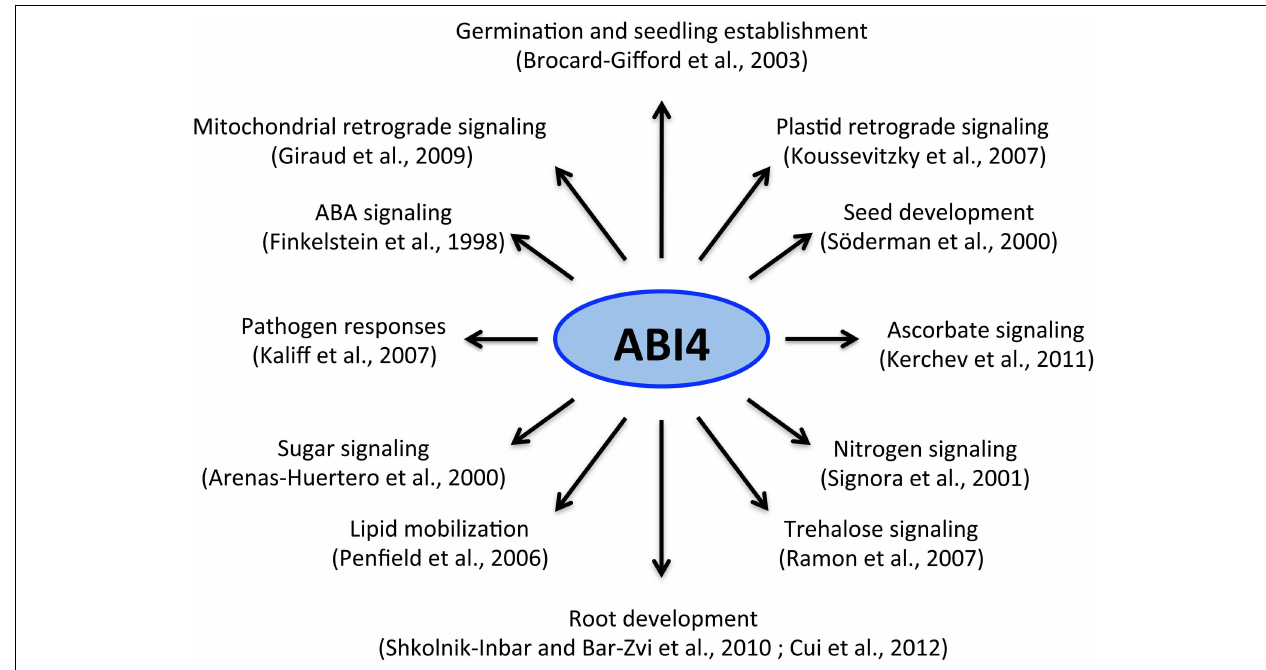
FIGURE 1 |ABI4 and its role in plant growth and development. ABI4 acts as a node of convergence of multiple signals that regulate different processes during plant development.